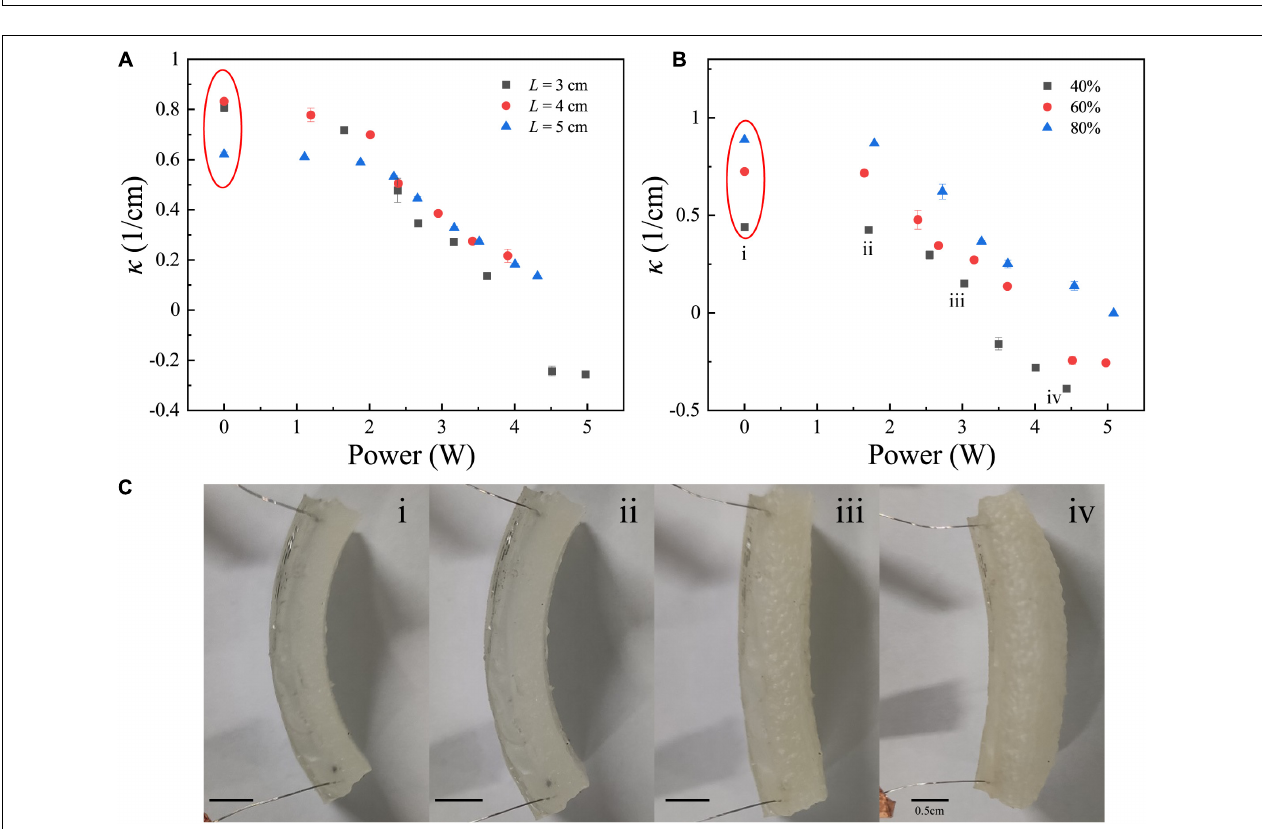
FIGURE 2 | Bi-directional deformation of pre-strained bilayer structure. Schematic of deformation of slender pre-strained bilayer structure (A) and of wide pre-strained bilayer structure (B) .